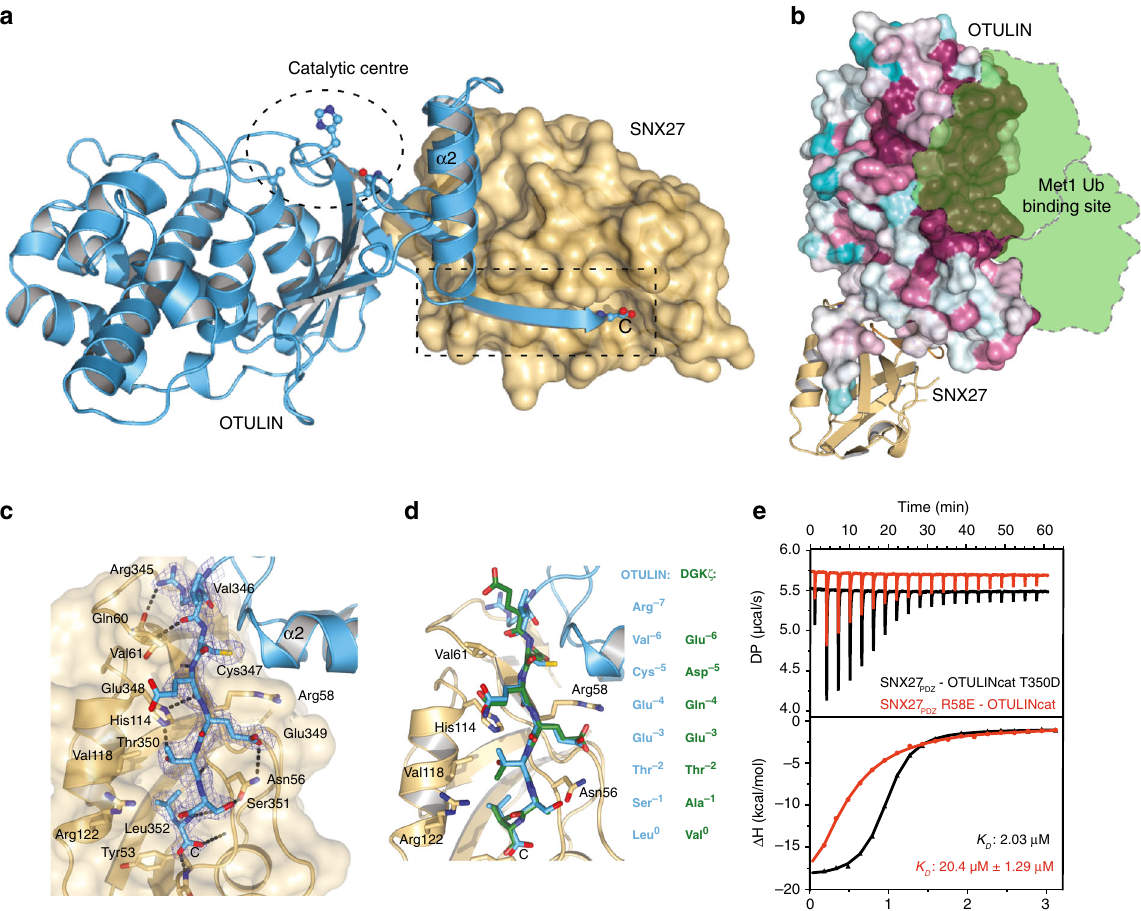
Fig. 3 Structure of the OTULIN-SNX27 complex revealing the canonical PDZ-PDZbm interface. a Structure of OTULIN (blue cartoon) bound to SNX27 (brown surface). The OTULIN catalytic center and also the OTULIN PDZbm are highlighted (dotted lines). b Surface representation of OTULIN colored based upon conservation calculated through the Consurf webserver. The binding site for Met1 diubiquitin is shown as cartoon from superimposition of the OTULINcat Met1 diubiquitin structure (PDB: 3ZNZ). c Close-up view of the interaction between OTULIN PDZbm and SNX27 PDZ rotated 90° from enclosed box in a . A weighted 2Fo-Fc map is shown for residues from the OTULIN PDZbm contoured at 1.1 σ . Hydrogen bonds are denoted by dotted lines. d Additional residues from OTULIN PDZbm engage with SNX27. A canonical PDZbm cargo of SNX27 (DGK ζ ; PDB: 5ELQ) (green) is superimposed onto the OTULIN-SNX27 structure. Residues at each position are shown and numbered according to convention. e Mutation of the canonical binding site disrupts the interaction between OTULIN and SNX27. ITC data for either a single point mutation within the OTULIN PDZbm (black) or SNX27 PDZ (red) are